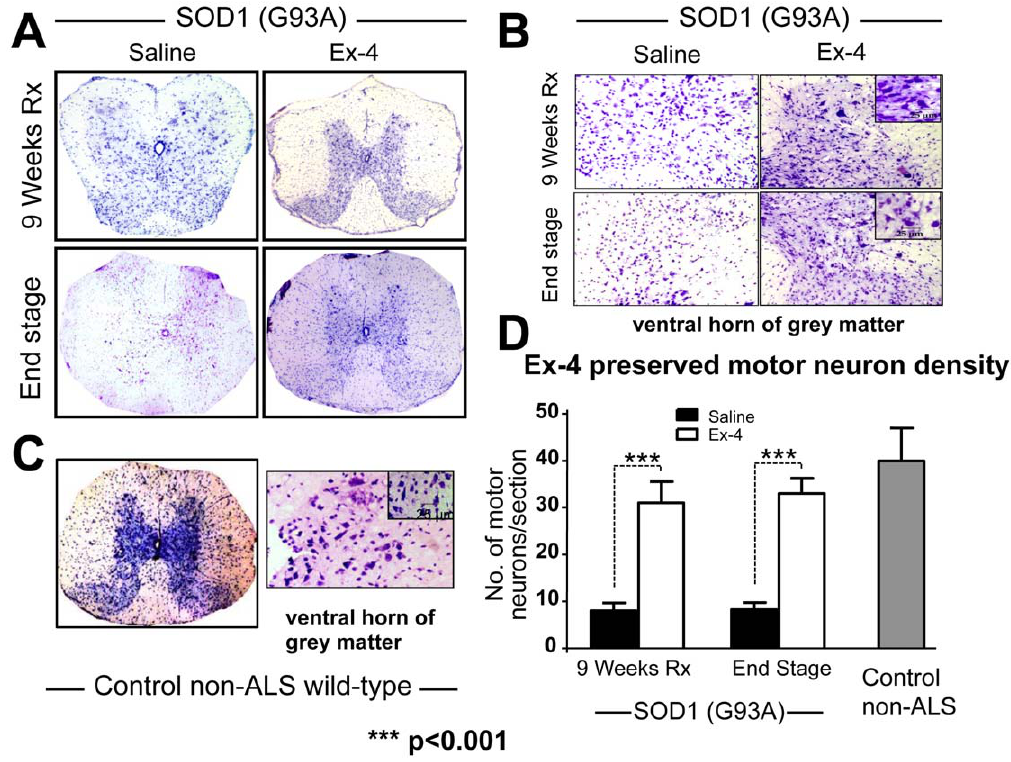
Figure 6. Ex-4 treatment preserved lumbar spinal cord structure and neuron density. ( A ) Cresyl violet staining of lumbar spinal cord section of SOD1 (G93A) mice at both early (9 weeks of treatment at a pre-symptomatic stage) and end stages of disease. ( B ) Close-up of ventral horn of grey matter shows staining of motor neurons with large soma, scale bars on right inset is 25 m m. By comparison, ( C ) demonstrates similar lumbar spinal cord sections derived from control non-ALS WT mice, in which the grey matter tracts are clearly evident. ( D ) Quantification of motor neuron numbers in the ventral horn of grey matter. An approximately 3-fold greater neuron number was present in SOD1 (G93A) Ex-4-treated mice spinal cord sections than in vehicle-treated mice at both pre-symptomatic and end disease stages (9 and 12 week treatment times). Evaluation of motor neuron number in the lumbar ventral horn grey matter of age-matched control non-ALS WT mice were in the range of those present in SOD1 (G93A) mice treated with Ex-4. Selection of large pyramidal neurons was based on their characteristic nulceolus, angular and spindle-shaped [85]. A measuring bar of 25 m m is for reference only.